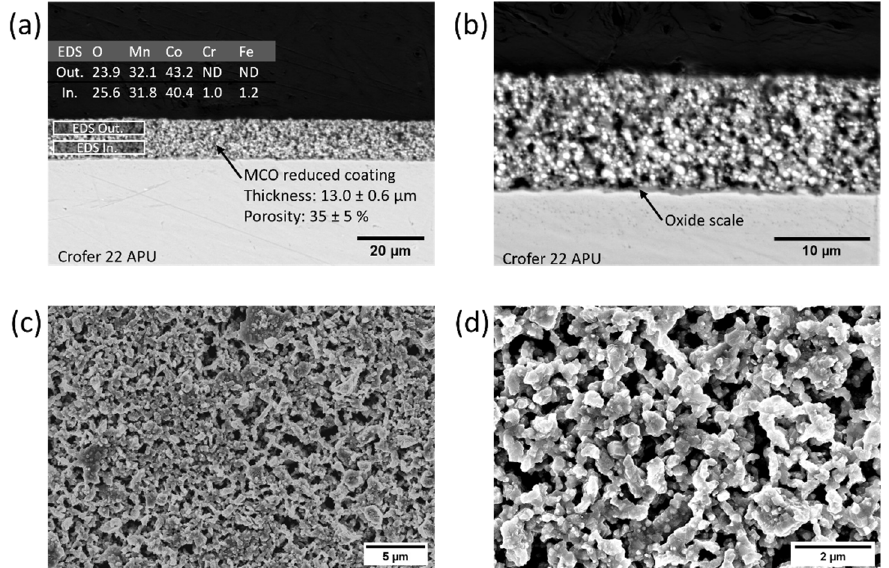
Figure 2. SEM images of 20s_Red sample at different magnifications: ( a , b ) backscattered electron images and EDX analysis of the cross section; ( c , d ) secondary electron images of the top view.